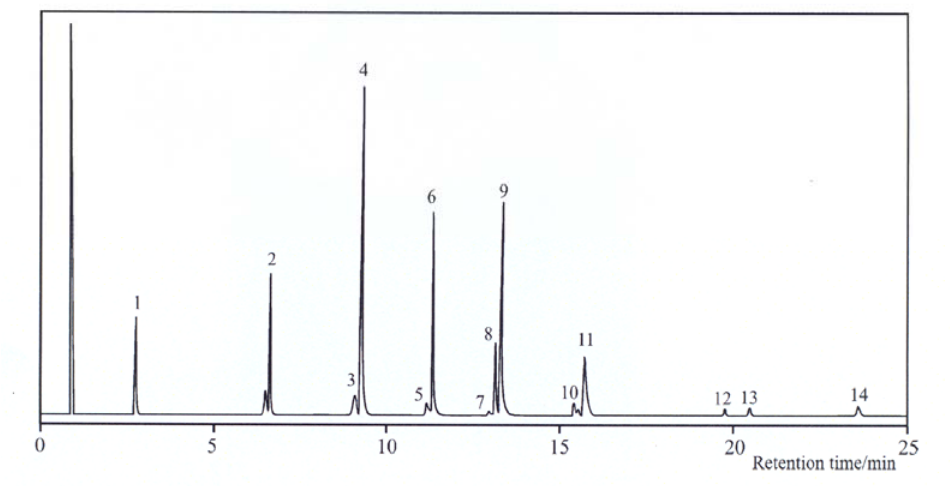
Figure 1. Gas chromatogram of the metathesis products of methyl linoleate: n -olefins (peaks 1-3, 5, 7), monoesters (peaks 4, 6, 8, 10, 12) and diesters (peaks 9, 11, 13,